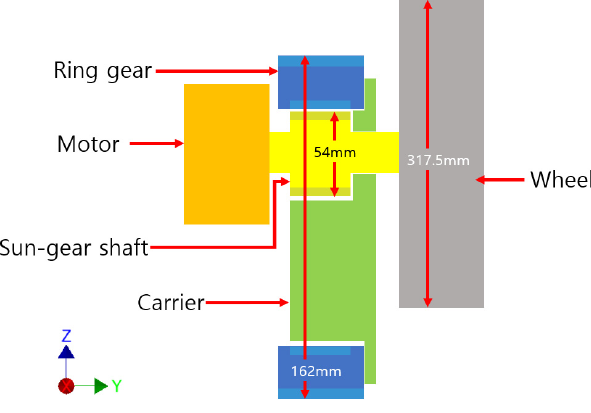
Figure 2. Dual-speed transmission structure drawing.